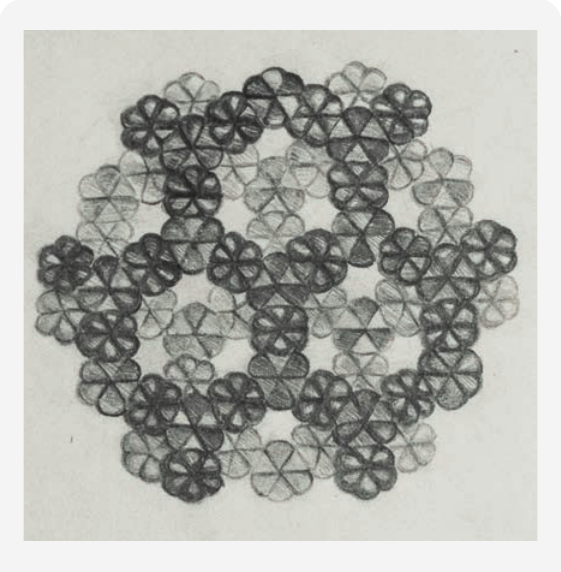
Fig. 7. Covalent organic framework-1 (COF-1) is an extended 2D framework with staggered